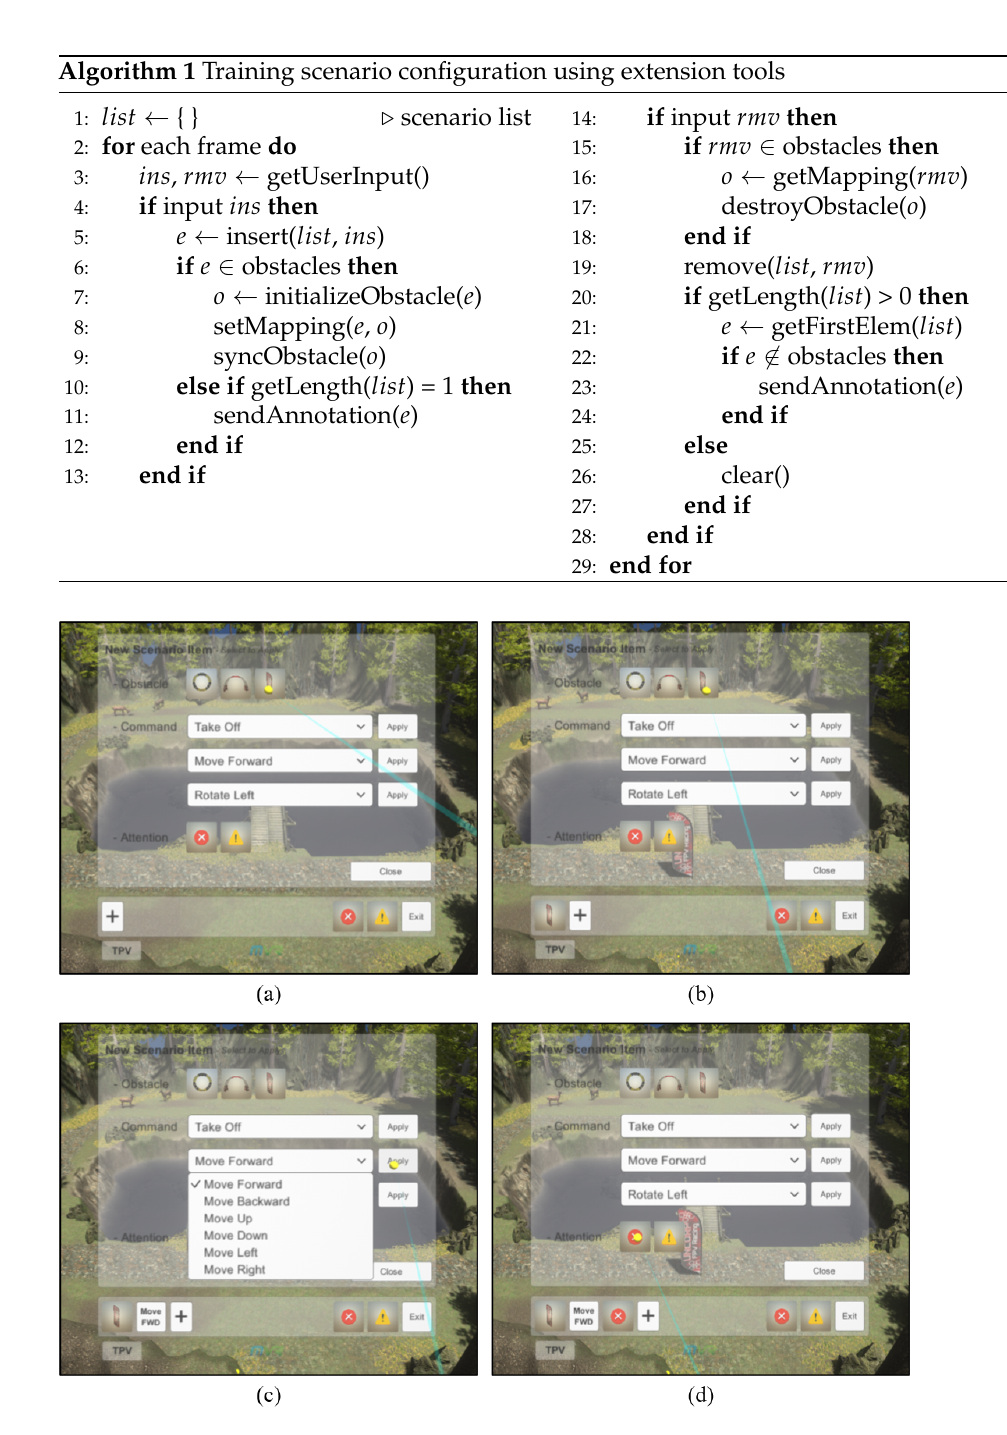
Figure 17. Configuration of sequential flight training scenarios using a controller. ( a ) Selection of an obstacle scenario ( b ) An inserted obstacle-icon in the interface ( c ) An inserted MOVE-FORWARD-icon in the interface ( d ) An inserted attention-icon in the